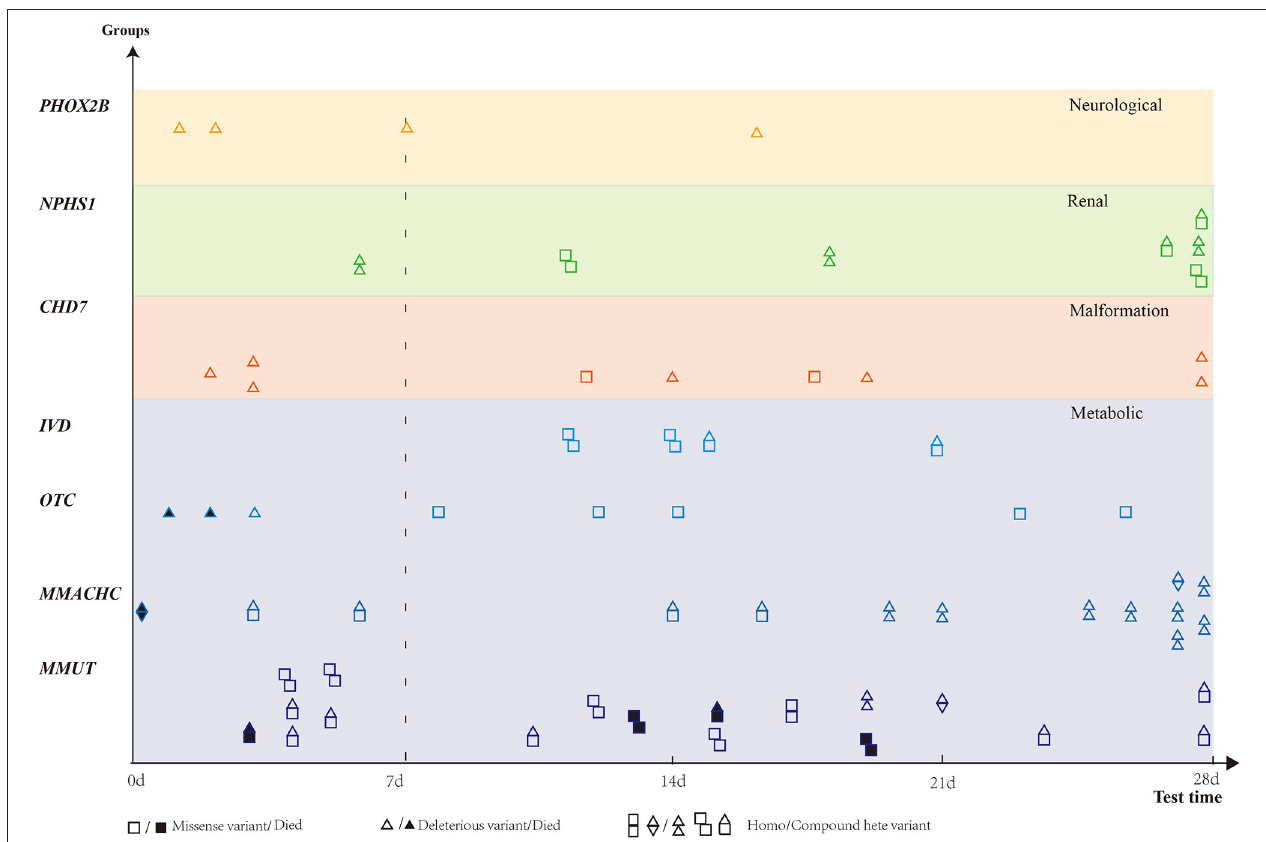
FIGURE 3 | Distribution of genes detected in more than four patients. Six genes were classified into four groups based on diseases. X-axis presents blood gas test time. Patients with missense variant are denoted by square, and deleterious variants are denoted by a triangle. Death is denoted by a solid black square or